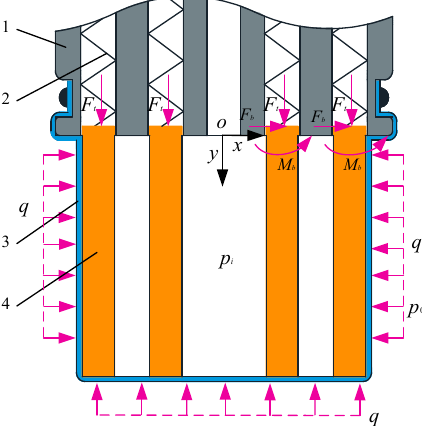
Figure 8. The overall force situation: 1, base: 2, spring; 3, balloon membrane; 4, bendable sliding pins.